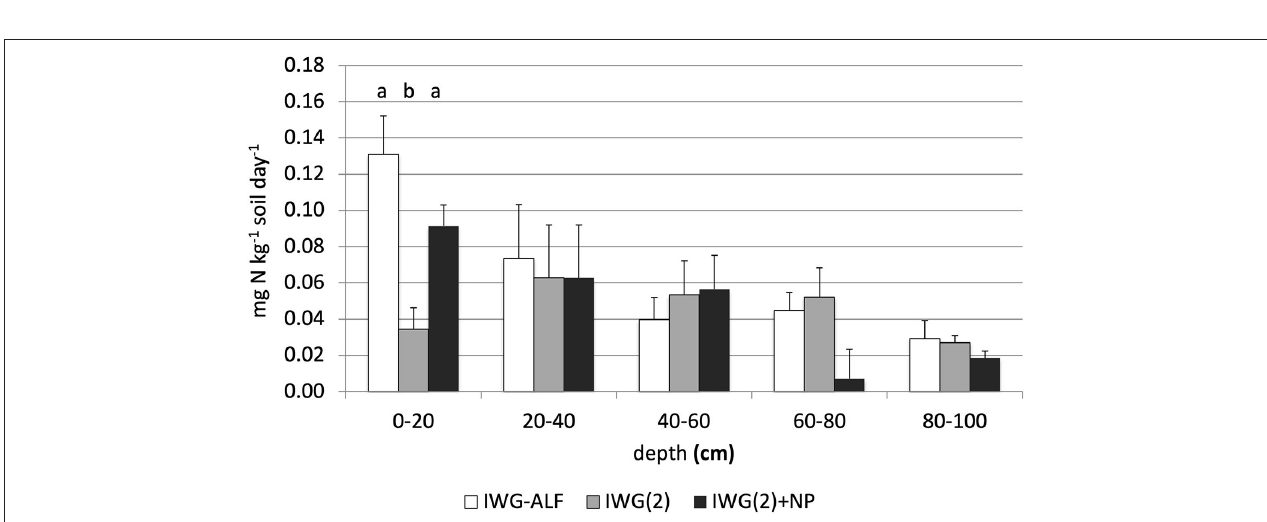
FIGURE 5 | SPAD values reflecting relative IWG leaf N status as influenced by crop density, diversity, and fertilization in 2014 and 2015. Bars with different upper and lower-case letters indicate significant differences between treatments in 2014 and 2015, respectively, at p < 0.05 (Tukey HSD). SPAD values from both years were log transformed to achieve normal distributions (not shown).